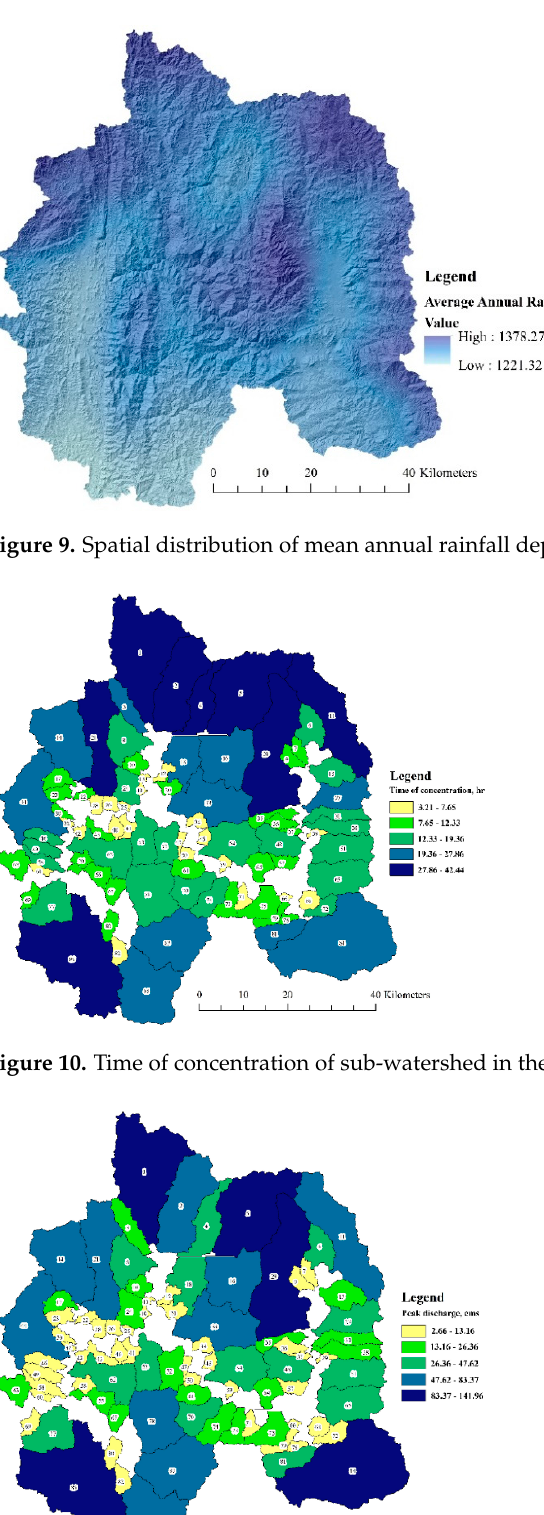
Figure 8. Annual rainfall between gauged rainfall data and the CHIRPS data (satellite-based rainfall) for before and after bias correction process.